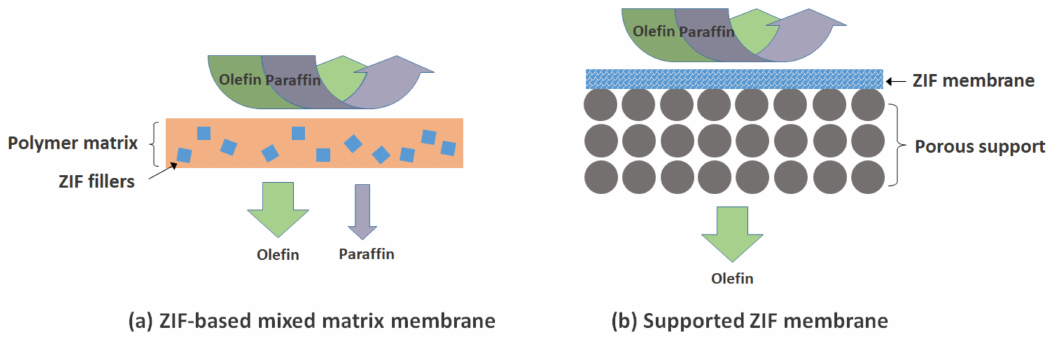
Figure 1. Schematic of ( a ) ZIF-based mixed matrix membrane and ( b ) supported thin film ZIF